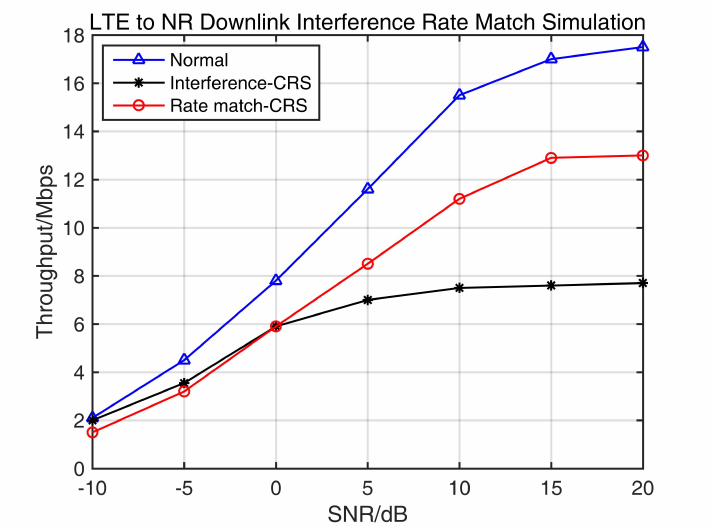
Figure 10. Simulation of rate matching.